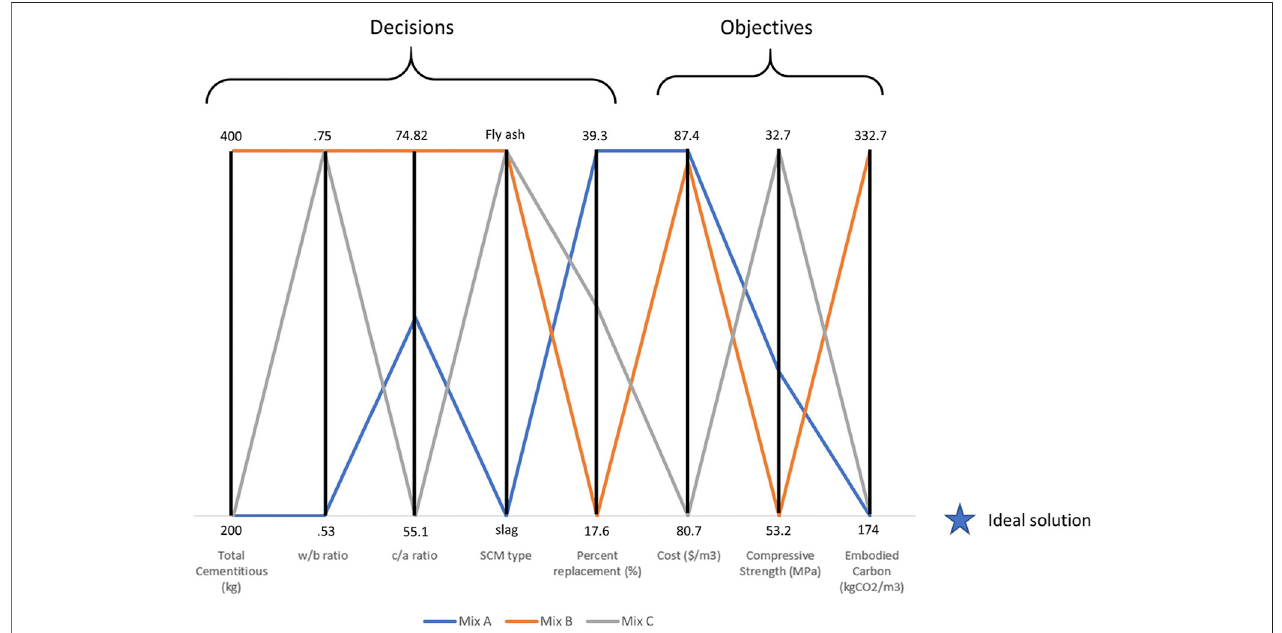
FIGURE 2 | Selection of three possible mix designs to illustrate trade-offs.Set of optimal mixture designs for Miami case study.